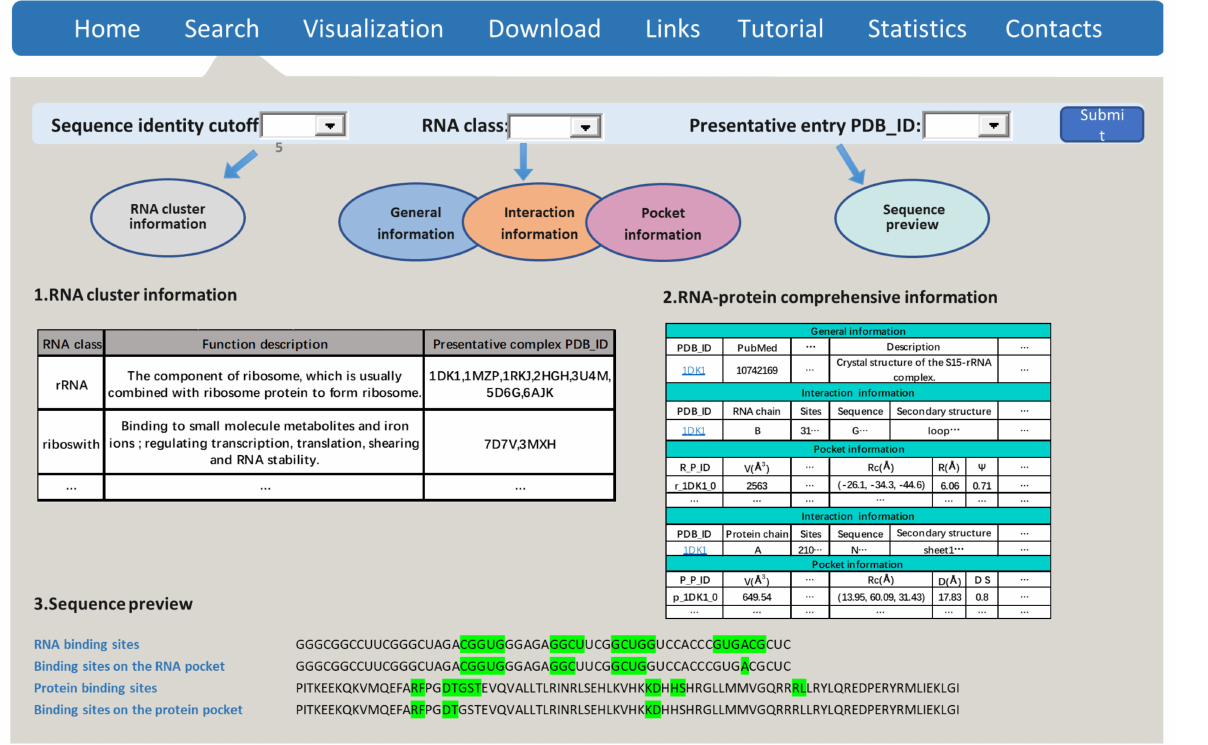
Figure 7. The search module of RPpocket. The user interface provides the RNA cluster, RNA–protein pocket topology, and sequence motif patterns. The sequence colored in green shadow represents the RNA-protein interaction or binding sites on the